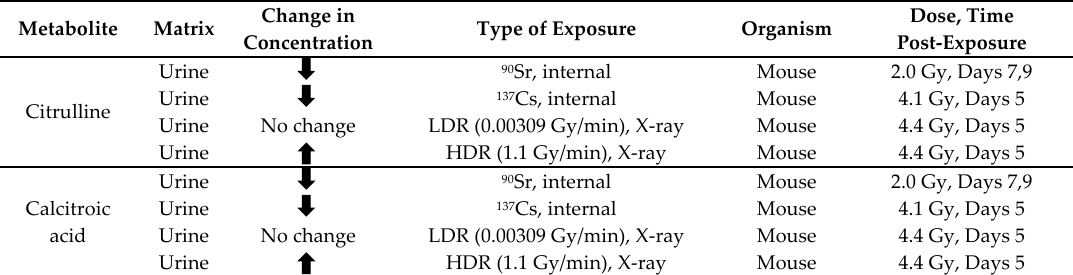
Table 2. Summary of studies on radiation-induced changes in the concentration of citrulline and calcitroic acid in urine. “No change” means no statistically significant changes in the urinary excretion of metabolites were detected